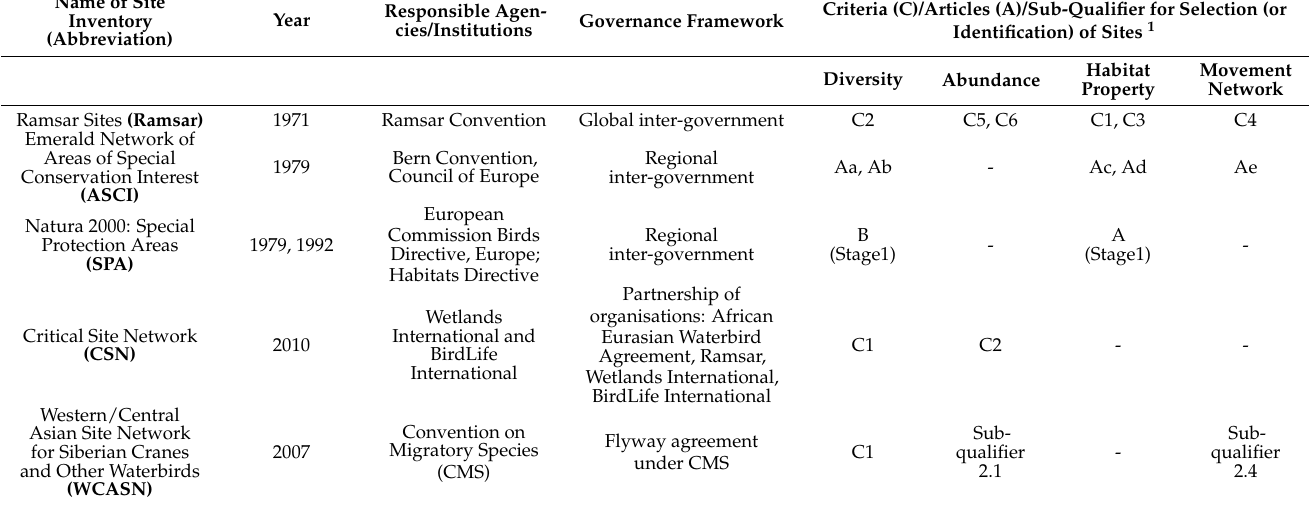
Table 1. Site selection criteria used in bird conservation